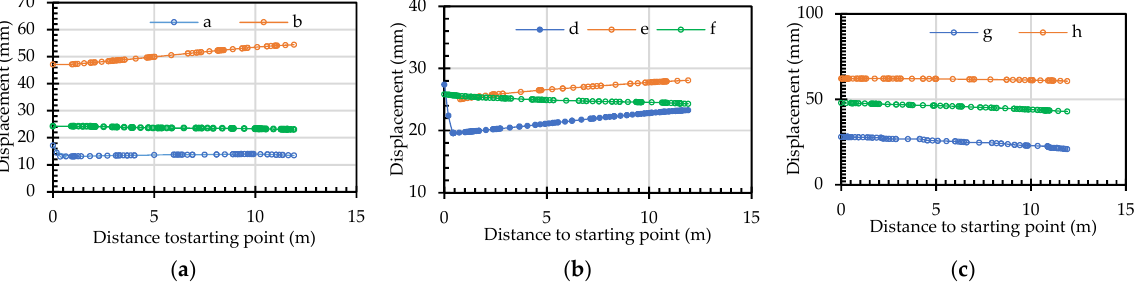
Figure 21. Displacement vs. location under biased pressure: ( a ) for pipe roofings a, b, and c in the westbound tunnel; ( b ) for pipe roofings d, e, and f in the MRT tunnel; and ( c ) for pipe roofings g, h, and i in the eastbound tunnel.